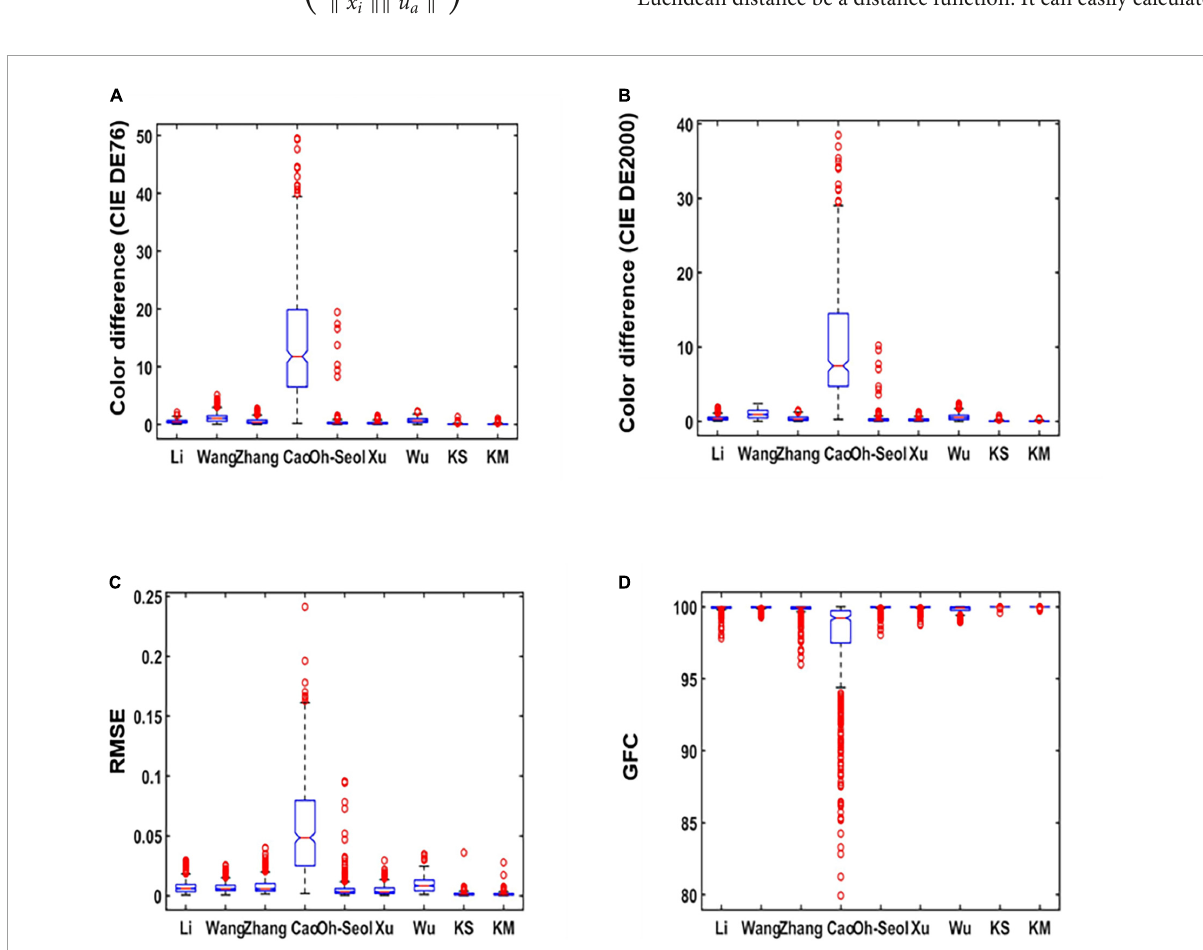
FIGURE4 Boxplots of simulated experiment results: (A) The International Commission on Illumination (CIE) DE1976 color difference, (B) CIE DE2000 color difference, (C) root-mean-square error (RMSE), and (D) goodness of fit coefficient